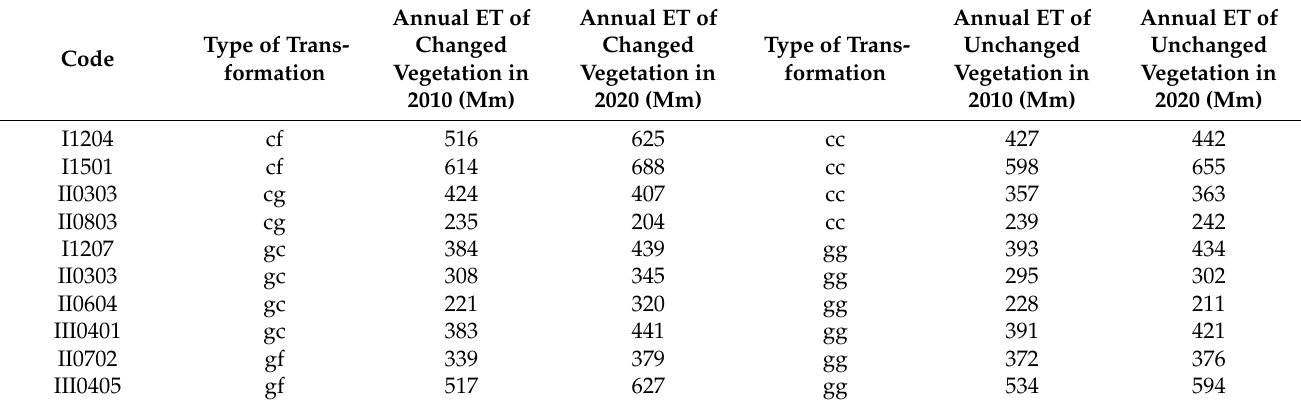
Type of Trans- formation